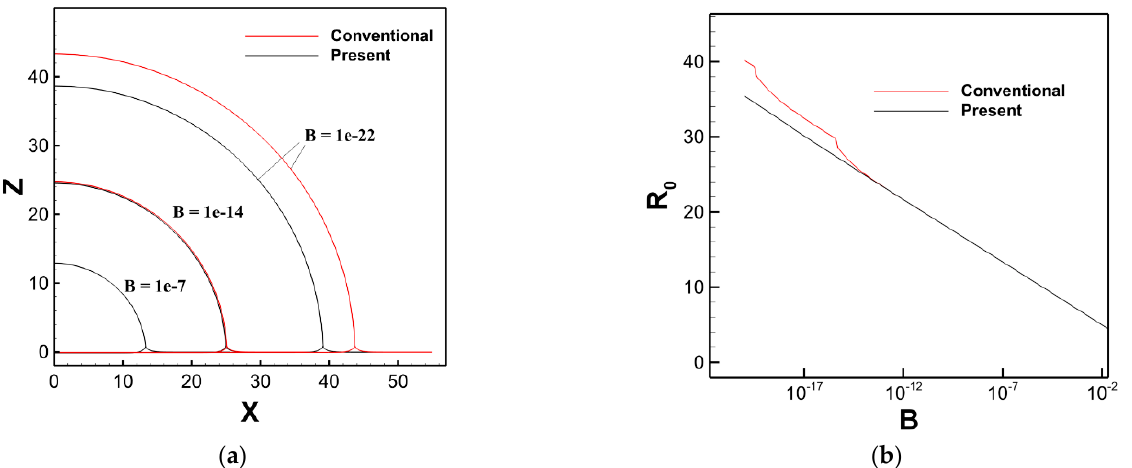
Figure 5. Comparison of the conventional (red) and the improved (black) methods for large bubbles. The tolerance of the ODE solver is set to 10 − 12 . ( a ) Floating bubble shapes for the following three large bubble sizes: B = 1 × 10 − 7 , 1 × 10 − 14 , and 1 × 10 − 22 . ( b ) The dimensionless cap radius R 0 is plotted with respect to the parameter B .